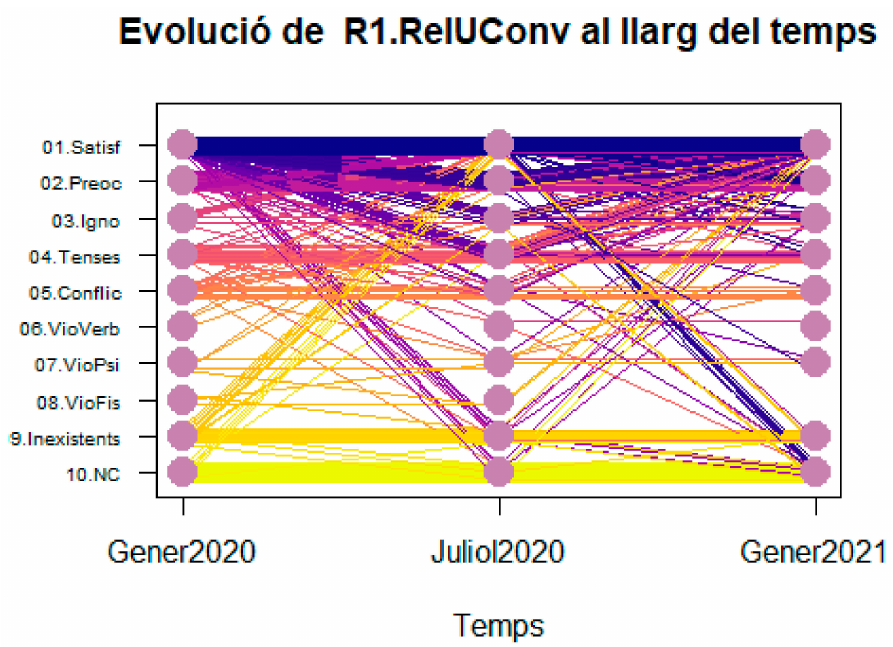
Figure 9. Trajectory map of question